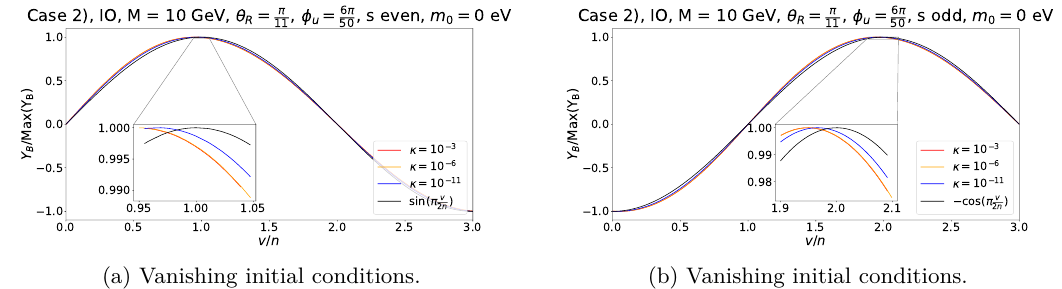
(b) Vanishing initial conditions. , treated as continuous parameter, for a Majorana mass Figure 31 . Case 2) Y B as function of v n M = 10 GeV and different values of κ , κ ∈ { 10 − 3 , 10 − 6 , 10 − 11 } . Light neutrino masses have strong